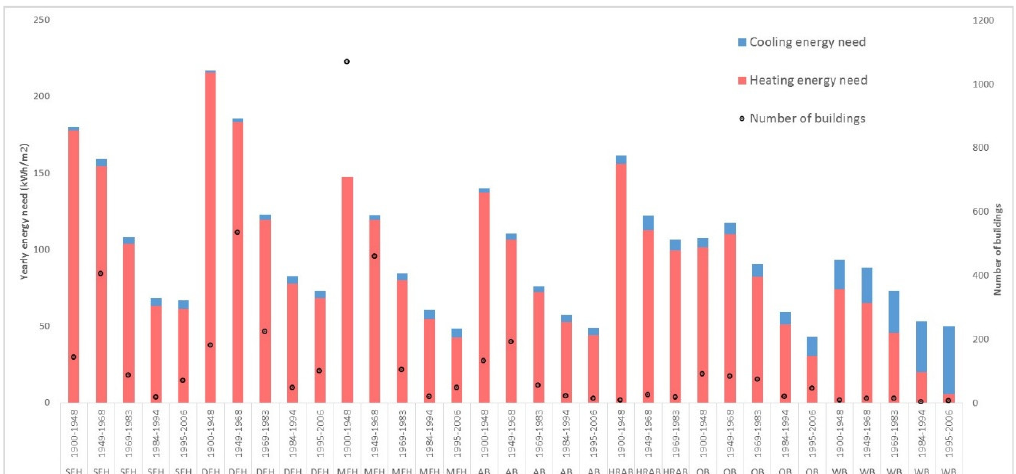
Figure 5. Annual specific building heating and cooling energy needs in 33 building typologies and corresponding number of buildings in each typology (SFH = Single Family House, DFH = Double Family House, MFH = Multi Family House, AB = Apartment Block, HRAB = High Rise Apartment Block, OB = Office Building, WB = Workshop Building).